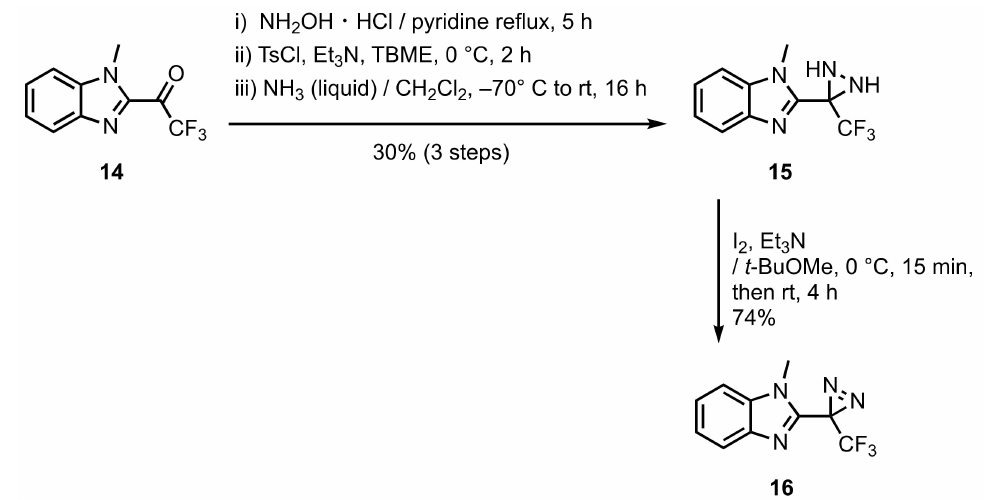
Scheme 2. The synthesis of diazirinyl benzimidazole